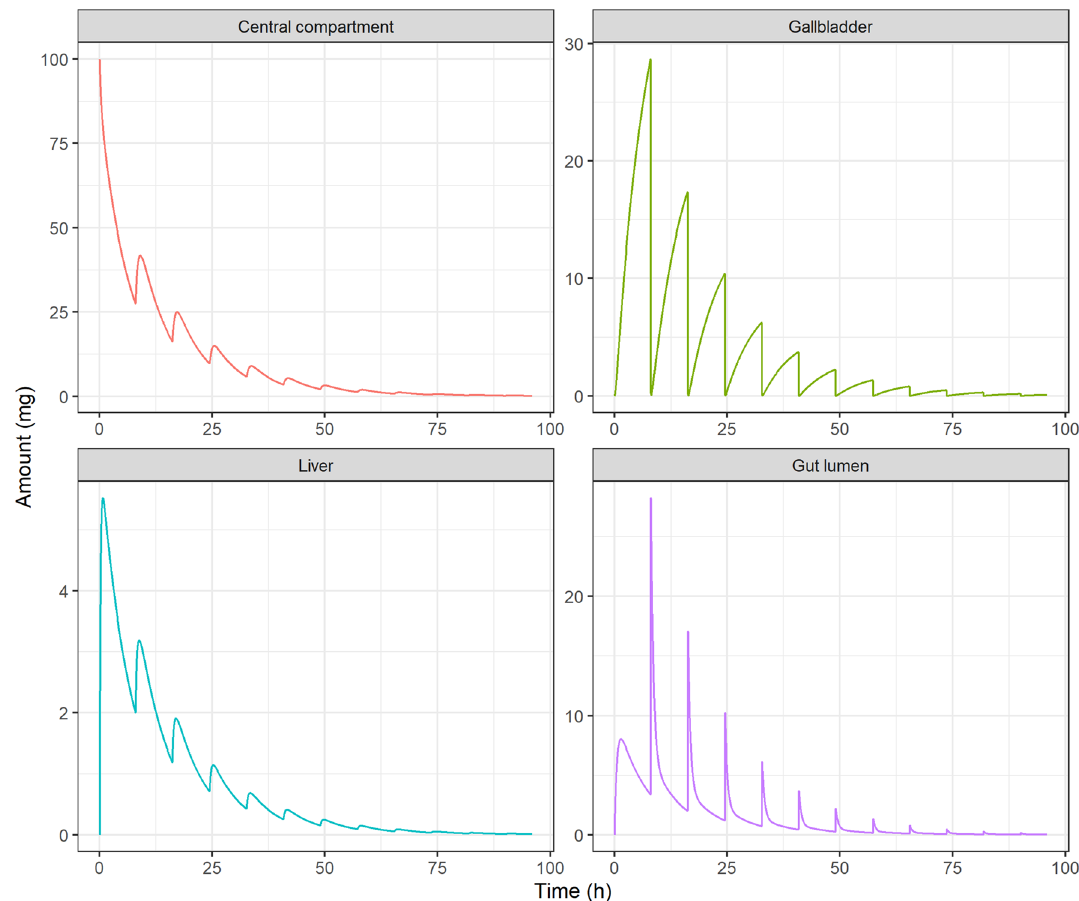
Figure 3. Pharmacokinetic profiles simulated for an intravenous administration of 100 mg, drug A, in the EHR model. Drug amounts in the central compartment ( A C ), gallbladder ( A B ), liver ( A H ) and gut lumen ( A G ) are plotted versus time after dose. The multiple-peaking nature of the profiles corresponds to discrete gallbladder emptying events taking place every 8 h after meal intake and followed by drug reabsorption into the central